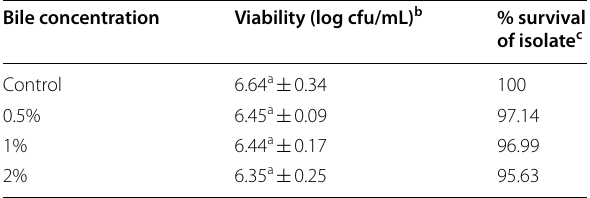
Table 4 Bile tolerance of P. kudriavzevii Y33 after 3 h of